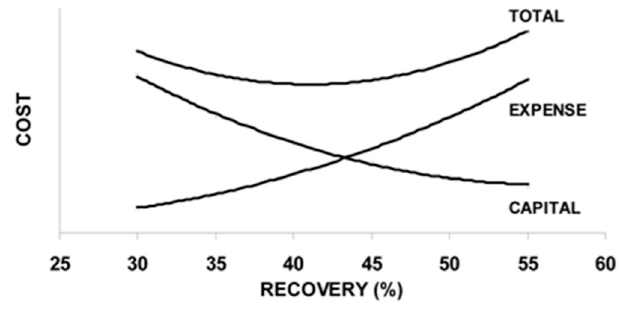
Figure 10. The overall plant cost optimization diagram [ Error! Reference source not found. ].